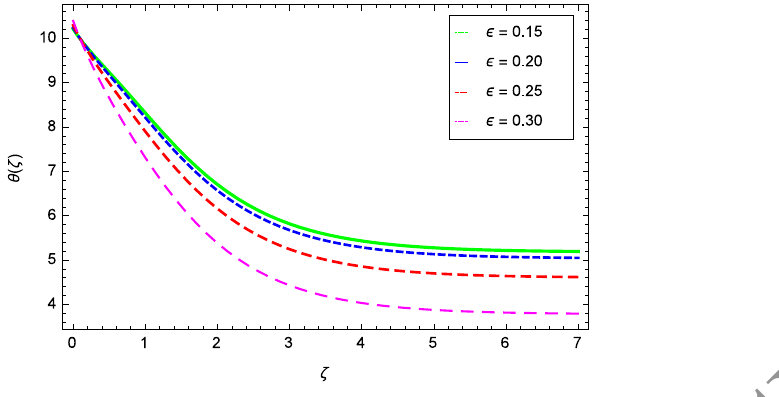
Figure 25. Effect of ǫ on temperature θ(ζ) .